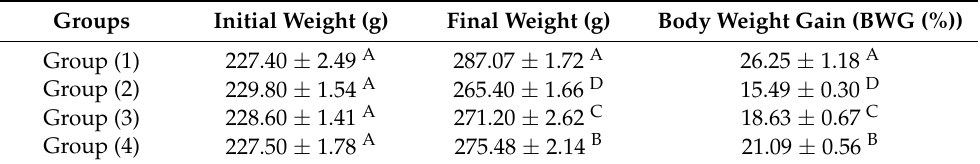
Table 2. Final weight (g) and body weight gain (%) in rats treated with yogurt fortified with 0.4% aqueous Hawthorn leaf